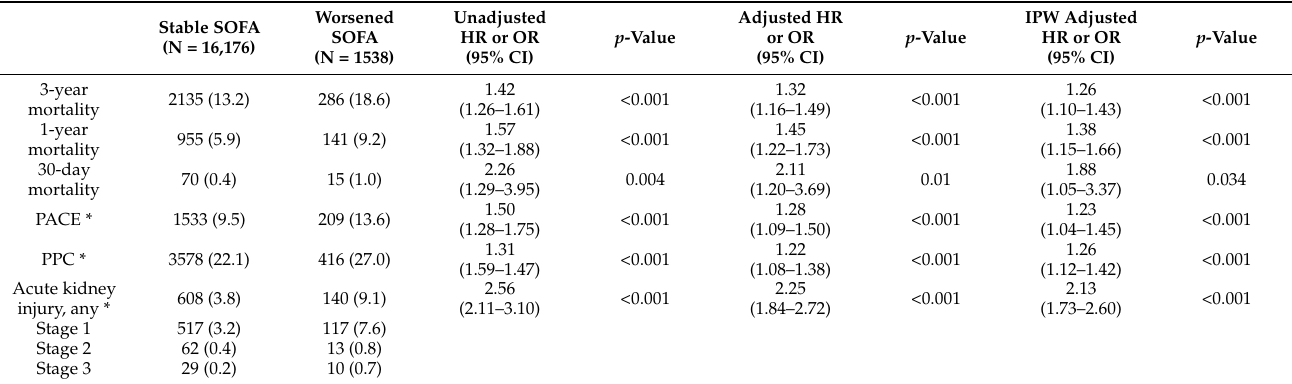
Table 3. Mortalities according to perioperative adverse cardiac event